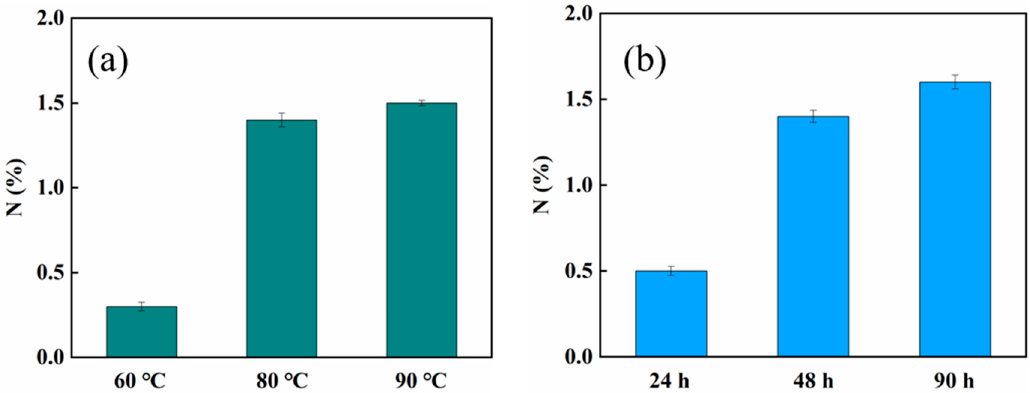
Figure 2. Content of nitrogen element in MCM- g -AB15C5 at di ff erent reaction temperatures ( a ) and reaction times ( b